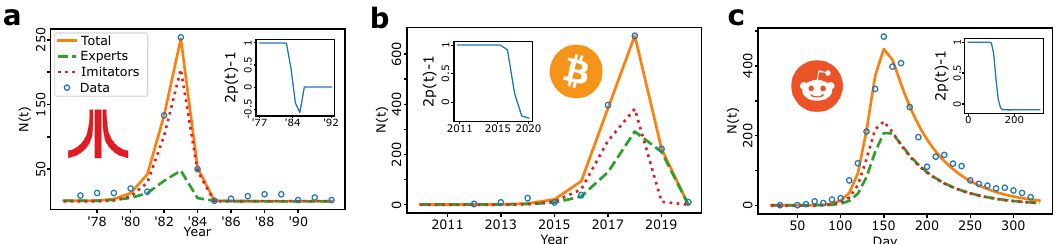
Fig. 4 Modeling the boom-and-bust pattern of cultural productivity. For a Atari 2600 video games, b cryptocurrencies, and c Reddit posts, we show the temporal dynamics predicted by the population-based model. We show the real cultural productivity, N ( t ) = x ( t ) + y ( t ), during that period (open blue circles), the predicted cultural productivity (orange solid line) and the population of experts x ( t ) and imitators y ( t ) at any given time t (green and red dashed lines, respectively). As an inset for each case, we report the expected population growth (2 p ( t ) − 1) due to product novelty p ( t ) in that period (see